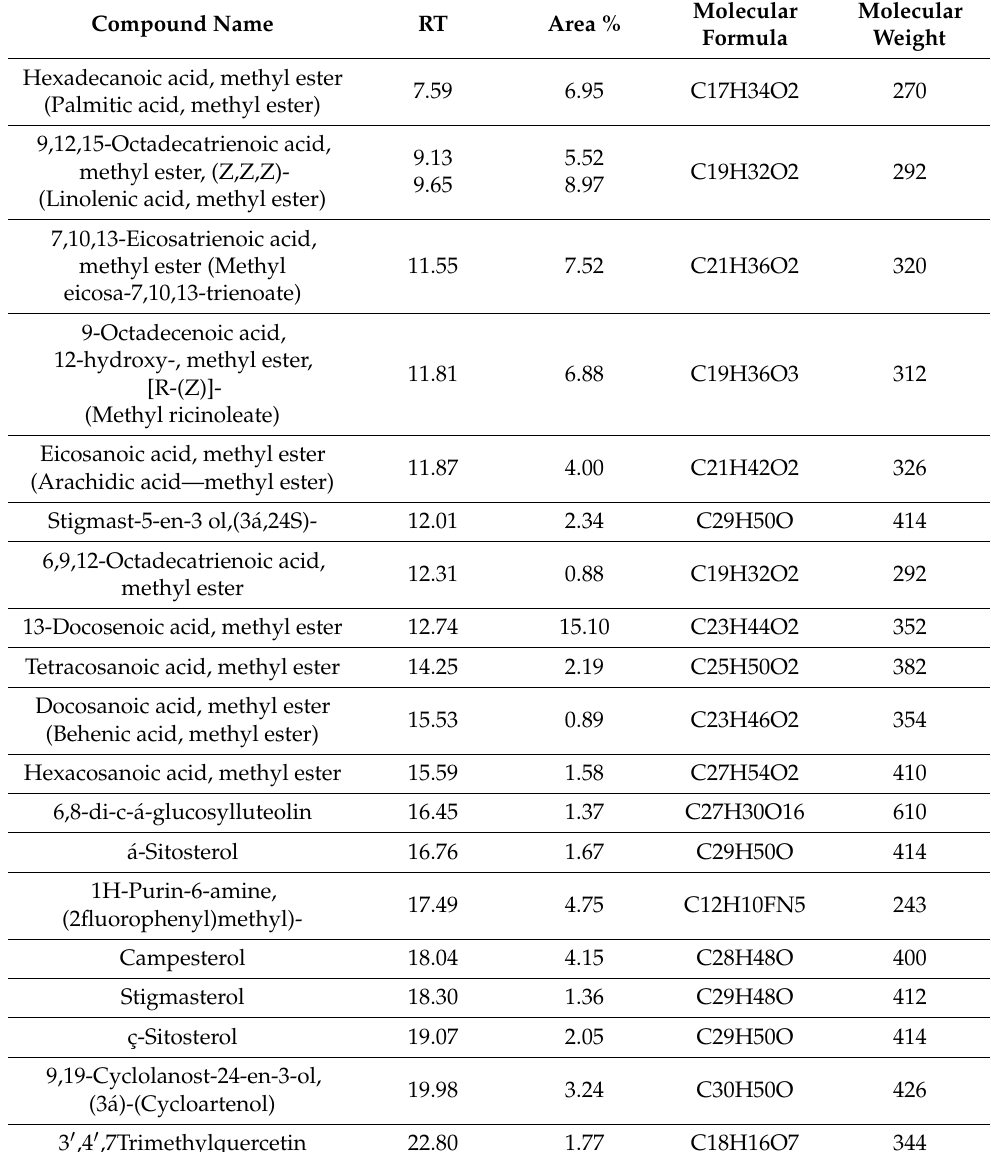
Table 3. GC-MS analysis of Opuntia ficus-indica seed